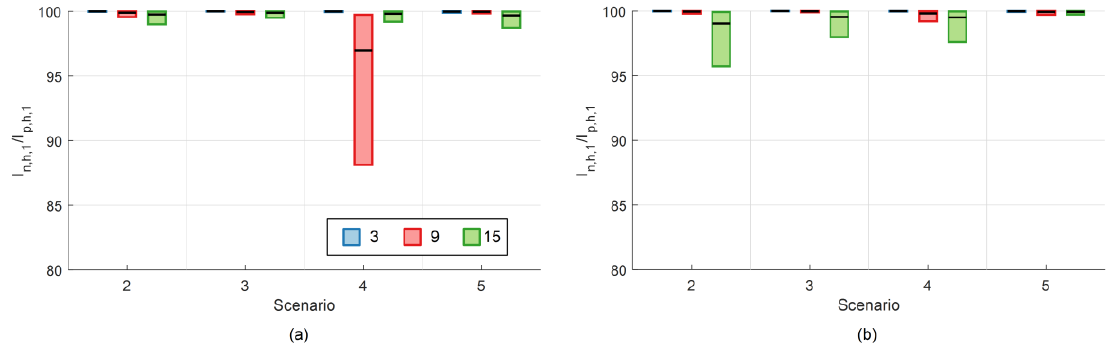
Figure 12. Deviation of zero-sequence harmonic currents from the ideal balanced case (100%) at analysis point 1: ( a ) sinusoidal and ( b ) flat-top.